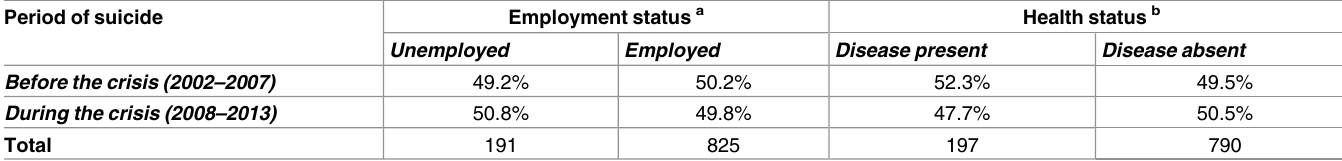
Table 2. Correlation between suicides happened before and during the economic crisis, suicide victims’ employment status and health status. Period of